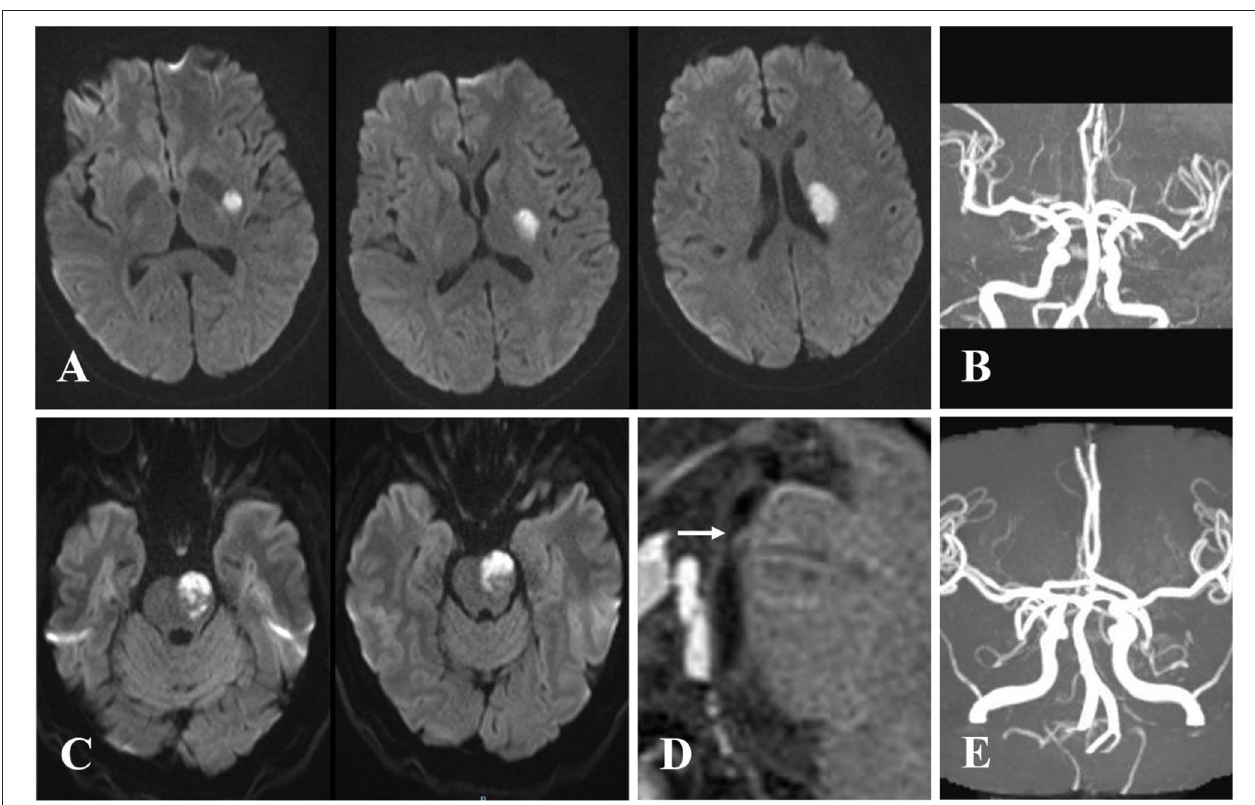
FIGURE 2 | Examples of cases with branch atheromatous disease (BAD). Case 1: A 57-year-old woman with right-sided weakness. (A) Diffusion-weighted imaging (DWI) showing cerebral stroke in the area of lenticulostriate artery. (B) Magnetic resonance angiography (MRA) illustrating no significant stenosis of parent artery. Case 2: A 61-year-old man with right-sided weakness and dysarthria. (C) DWI showing infarction extended to the ventral pontine surface in the area of paramedian pontine artery. (D) Vessel wall magnetic resonance imaging (VWMRI) depicting junctional plaque in the orifice of paramedian pontine artery. (E) MRA displaying no significant stenosis of basilar